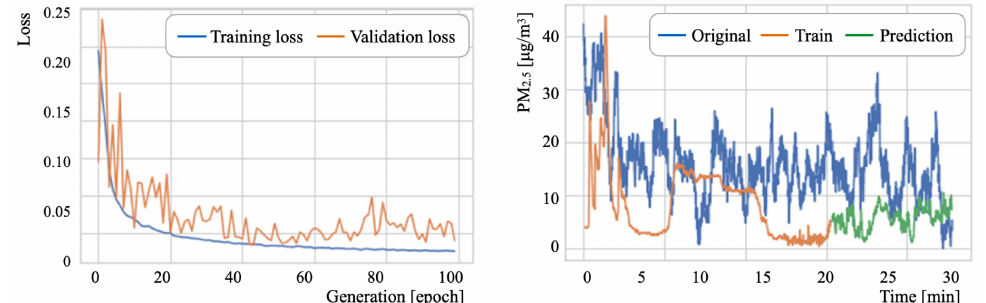
Figure 22. Loss curves and PM 2.5 prediction results for